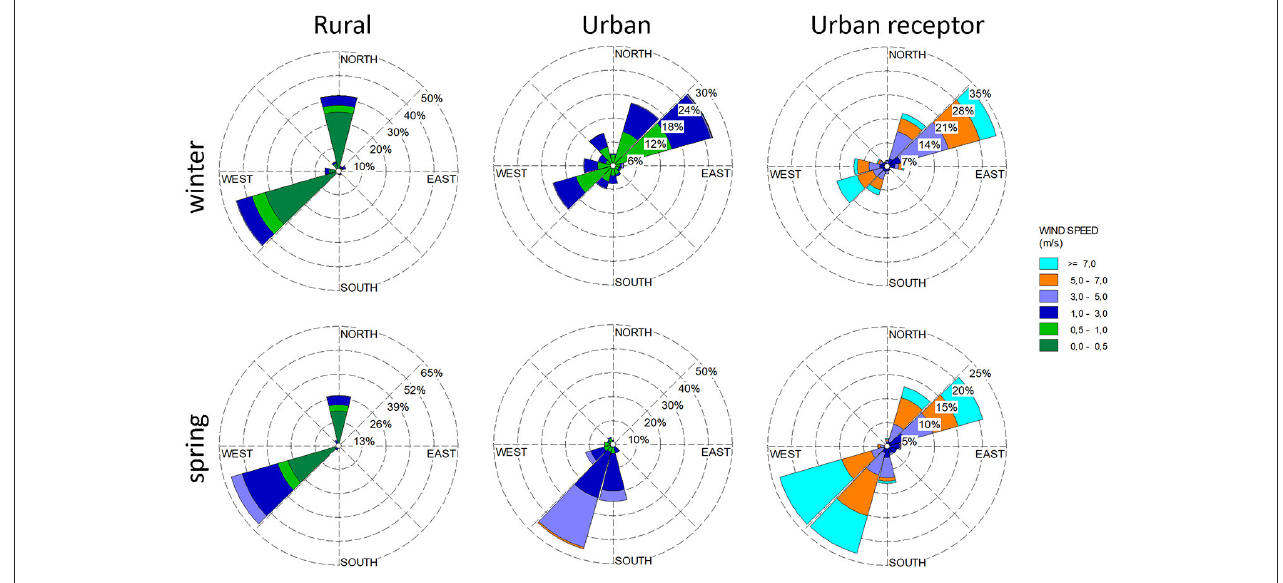
FIGURE 2 | Wind rose plots showing the winds speed (m/s), wind direction, and frequency in time (%) observed at the rural, urban, and urban receptor sites.